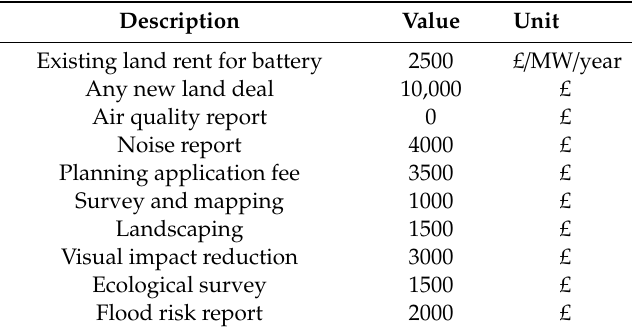
Table 1. Estimated non-battery costs (company proprietary data).